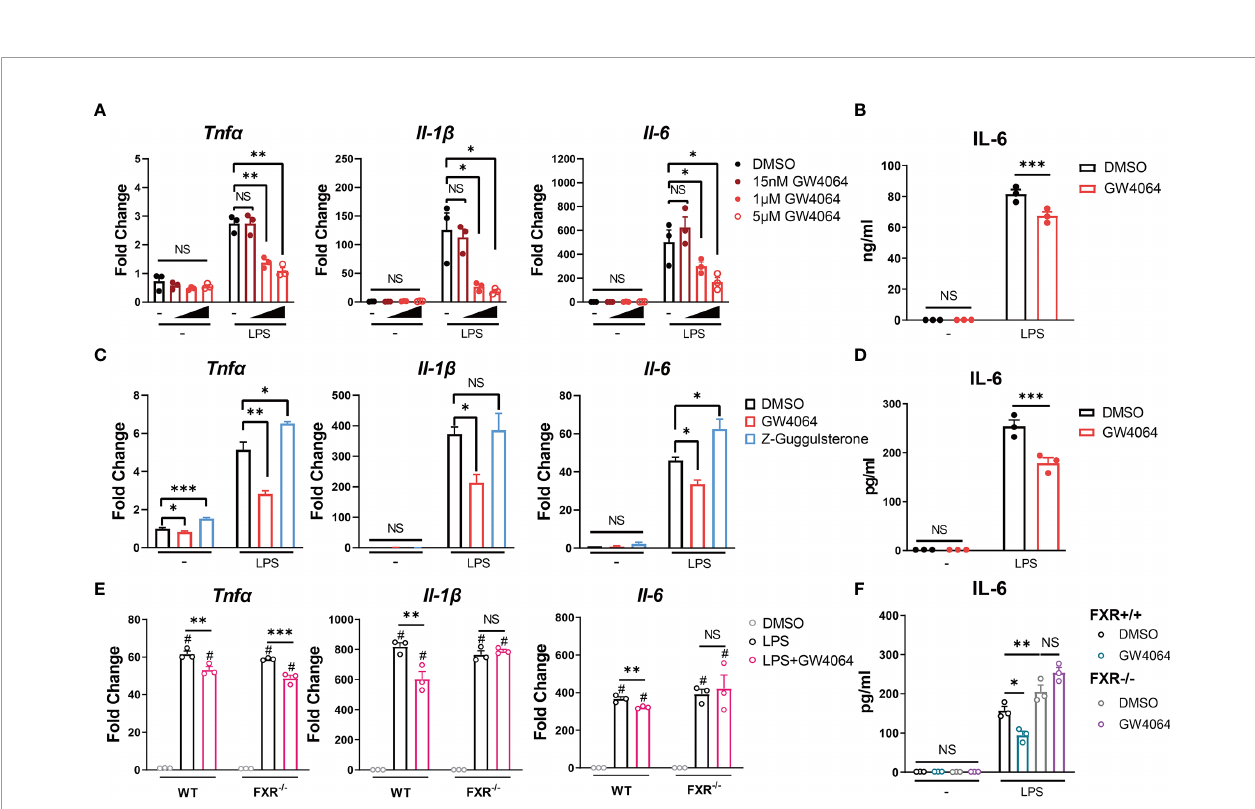
FIGURE 4 | FXR Agonist GW4064 Inhibits IL-6 Expression in Macrophages. (A, B) RAW 264.7 macrophages were incubated with or without different concentrations of FXR agonist GW4064 for 24h, and then stimulated with or without 100ng/ml LPS. (A) The mRNA levels of TNF a , IL-1 b and IL-6 from harvested cells at 6h after the stimulation are shown. (B) IL-6 levels in the supernatant from 24-hr cultures are shown. (C, D) Bone marrow-derived macrophages were incubated in the presence of DMSO, 5 m M GW4064 or 1 m M FXR antagonist Z-Guggulsterone for 24h. Cells were then stimulated with or without 100ng/ml LPS. (C) The mRNA levels of TNF a , IL-1 b and IL-6 from harvested cells at 6h after the stimulation are shown. (D) IL-6 levels in the supernatant from 24-hr cultures are shown. (E, F) Bone marrow-derived macrophages from FXR knockout (FXR − / − ) mice and the littermates were incubated with or without 5 m M GW4064 for 24h, and then stimulated with or without 100ng/ml LPS. (E) The mRNA levels of TNF a , IL-1 b and IL-6 from harvested cells at 6h after the stimulation are shown. (F) IL-6 levels in the supernatant from 24-hr cultures are shown. Data are shown as mean ± SEM. Experiments were repeated 3 times and representative data are shown. * p < 0.05; ** p < 0.01; *** p < 0.001; NS, no signi fi cant difference; # means compared to the relative unstimulated control group, two-way ANOVA, followed by Sidak ’ s multiple comparisons